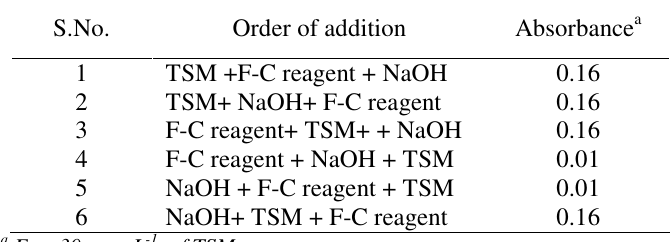
Table 1 . Effect of order of addition of reactants on color development S.No. Order of